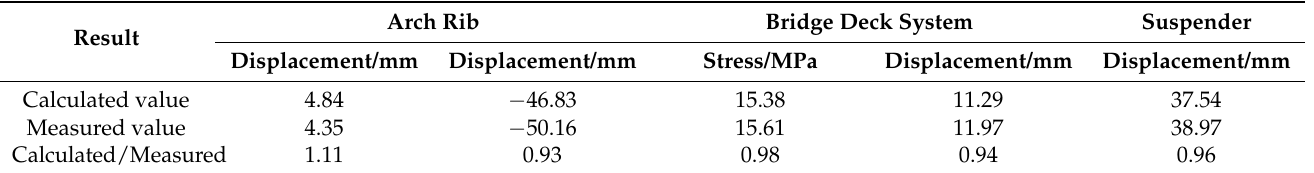
Table 2. Comparison of test and FEM results due to the 6# suspender broken (unit: mm).